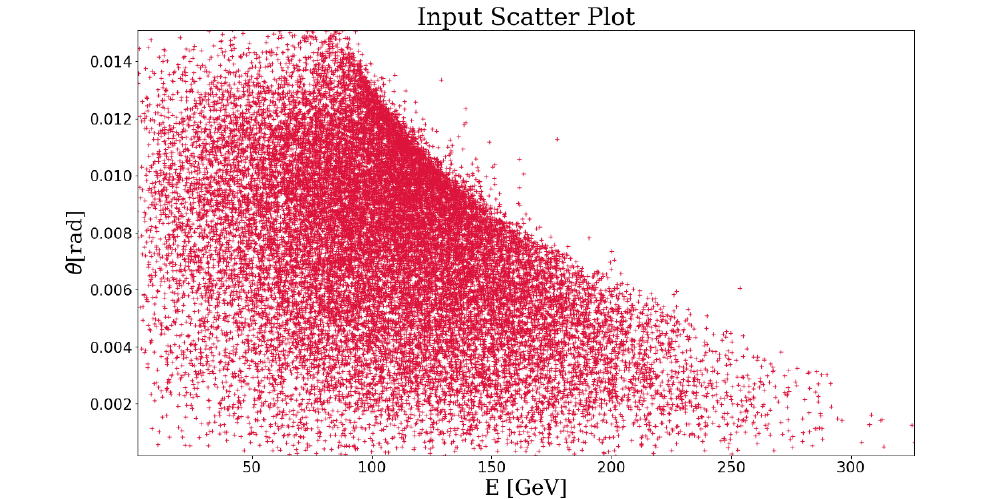
Figure 3. Input 2D-Scatter plot in the DM E (cid:0) (cid:18) plan. As example, we consider DM particles produced by a Dark Photon-like mediator, which enter a SHiP-like